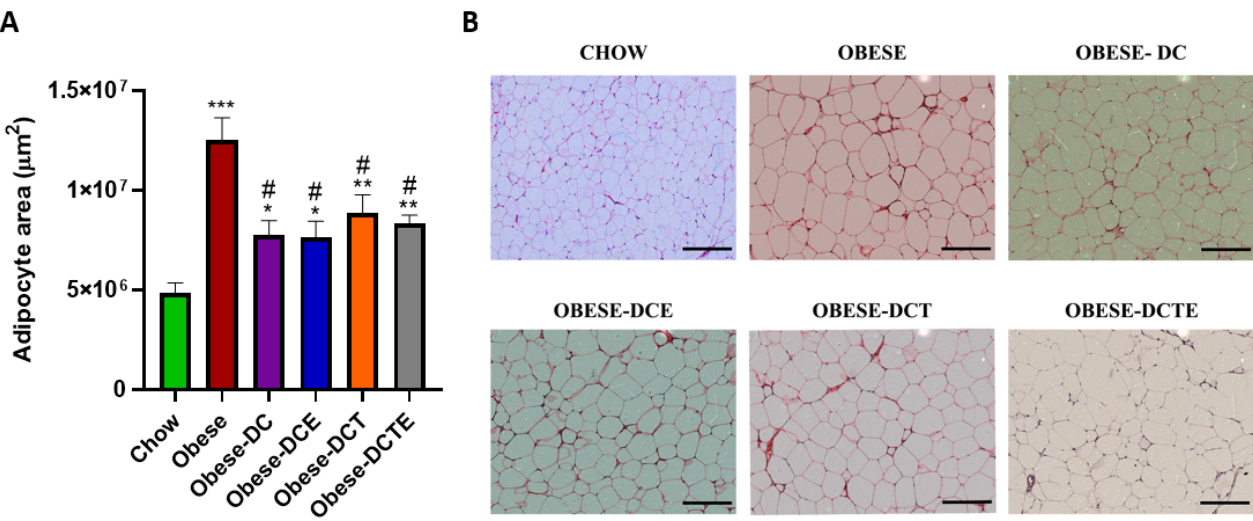
Figure 6. Size of adipocytes from visceral adipose tissue ( A ) and representative images of H/E dying in sections of visceral adipose tissue ( B ). The scale bar is equivalent to 200 µ m. Chow = mice fed a standard diet for 25 weeks; Obese = mice fed a high fat (60% kcal from fat)/high sucrose diet for 25 weeks; DC = mice fed a high fat (60% kcal from fat)/high sucrose diet for 23 weeks and switched to a diet with lower caloric intake (25% kcal from fat) for two weeks; DCE = mice fed a high fat (60% kcal from fat)/high sucrose diet for 23 weeks and switched to a diet with lower caloric intake (25% kcal from fat) supplemented with CSAT+ ® for two weeks; DCT = mice fed a high fat (60% kcal from fat)/high sucrose diet for 23 weeks and switched to a diet with lower caloric intake (25% kcal from fat) and subjected to aerobic training for two weeks; DCTE = mice fed a high fat (60% kcal from fat)/high sucrose diet for 23 weeks and switched to a diet with lower caloric intake (25% kcal from fat) supplemented with CSAT+ ® and subjected to aerobic training for two weeks. Values are represented as mean ± SEM; n = 8–10 mice/group. * p < 0.05 vs. chow; ** p < 0.01 vs. chow; *** p < 0.001 vs. chow; # p < 0.05 vs. obese.